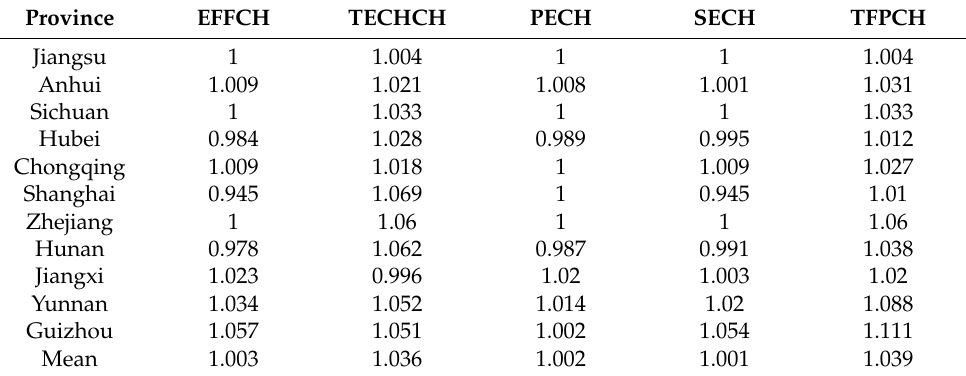
Table 6. Evaluation of the adjusted APE of the provinces in the YREB from 2010 to